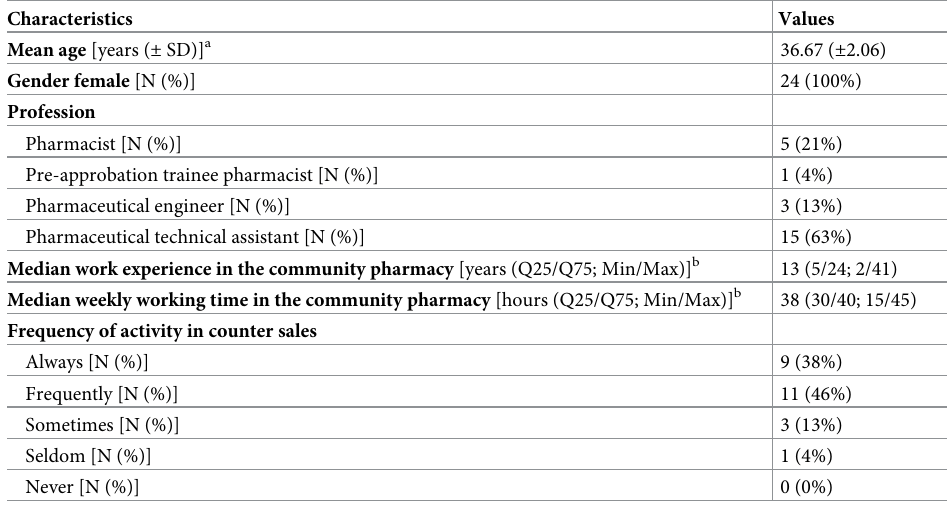
Table 2. Characteristics of participants in the non-participant observation (study part B) [N total =